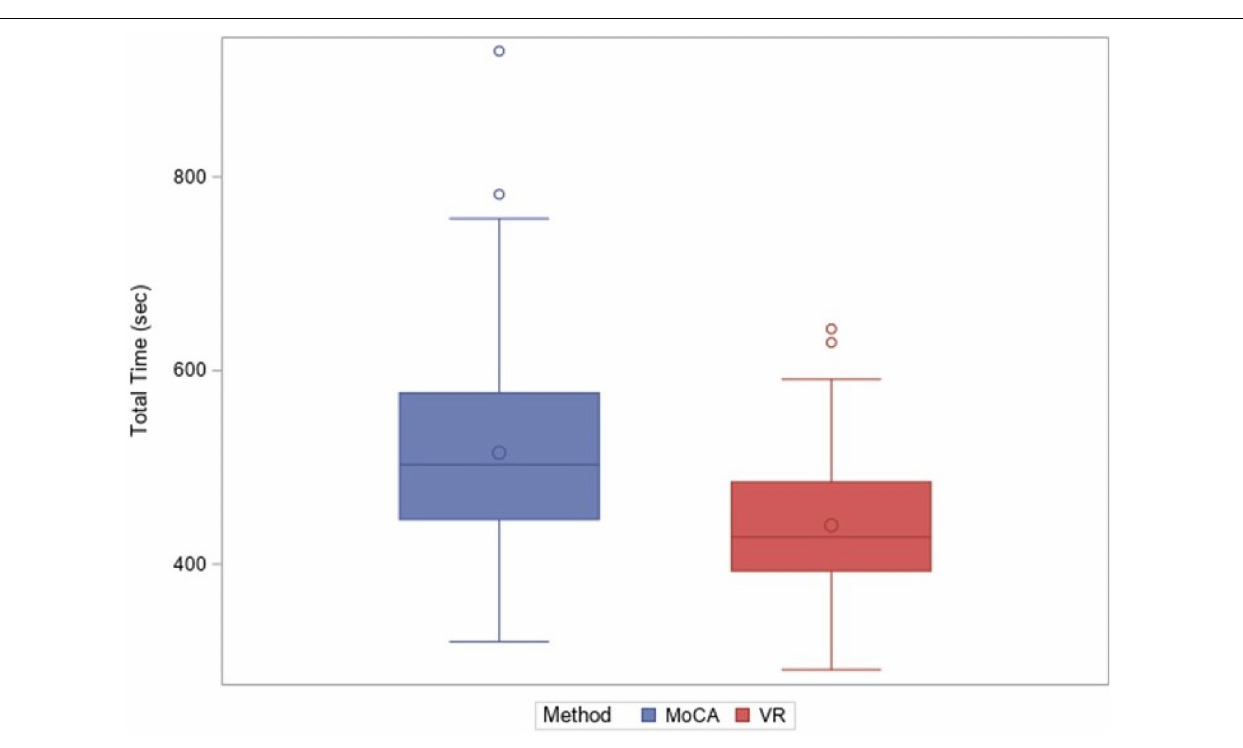
FIGURE 3 | Total time taken (sec), MoCA vs. Virtual Reality (CAVIRE),